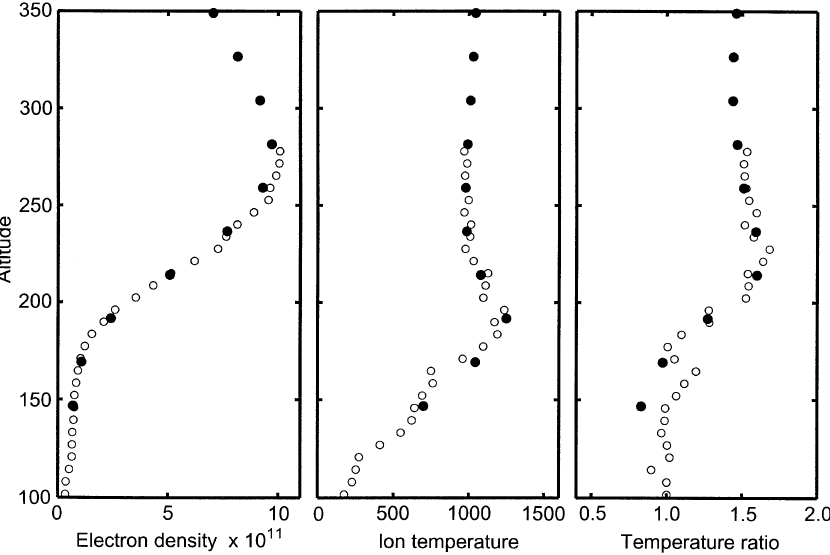
Fig. 6. Analysis results based on the alternating-code ( open circles ) and long- pulse ( full circles ) modulations. The data is measured on 16 February 1993, at 1110 — 1140 UT by the EISCAT UHF radar